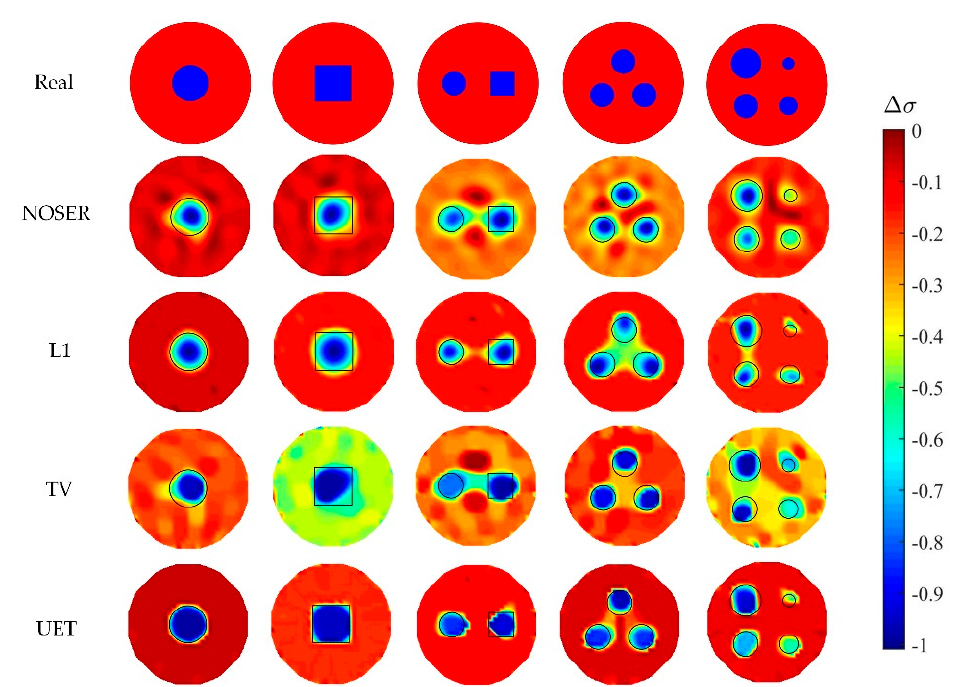
Figure 8. Reconstruction results with 20 dB noise.